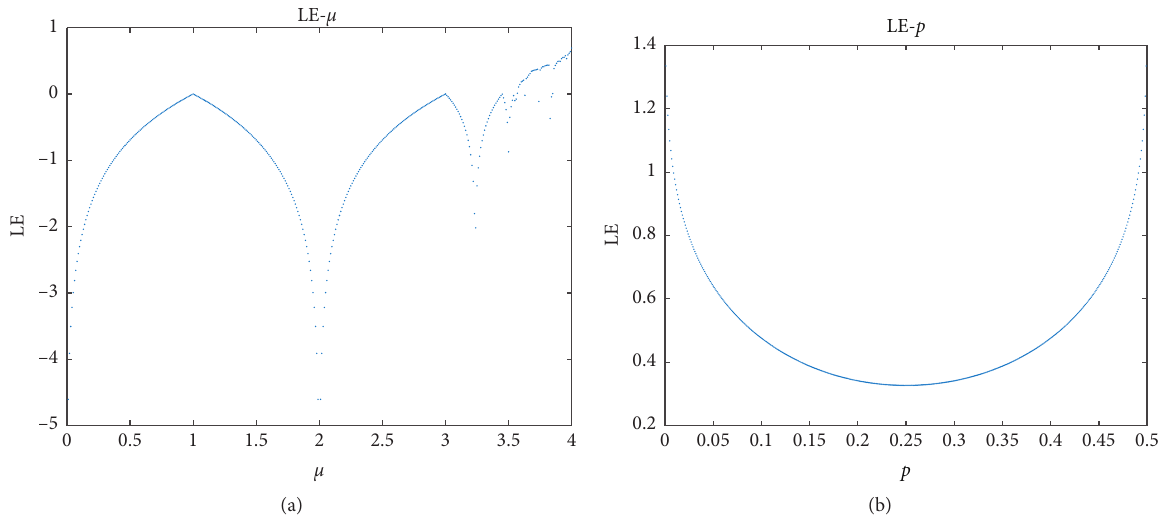
Figure 2: The Lyapunov exponent (LE) analysis: Lyapunov exponent curves of (a) logistic map and (b)